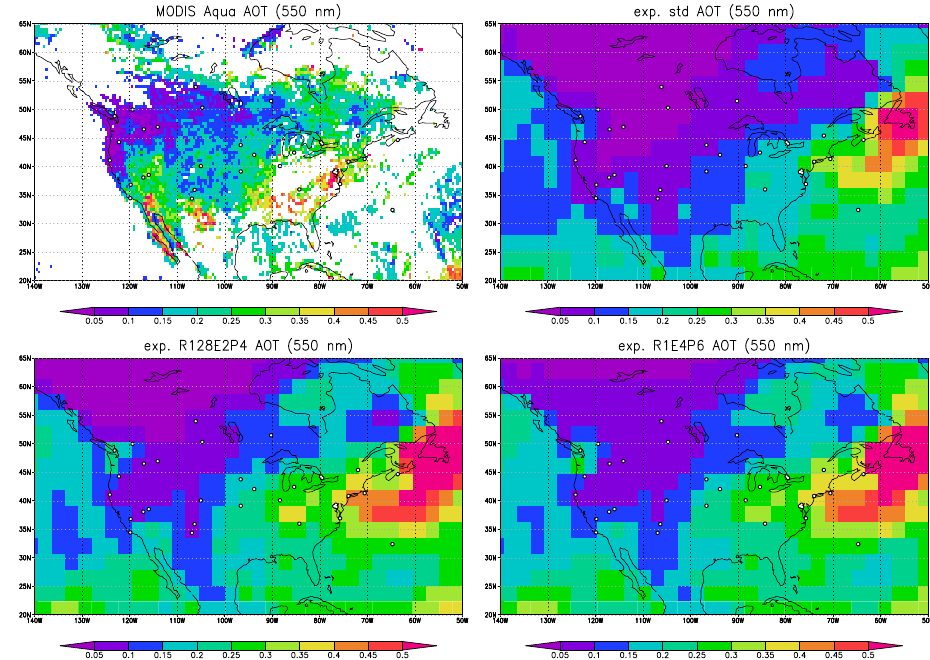
Fig. 18. AOT over North America for MODIS Aqua observations and several experiments.